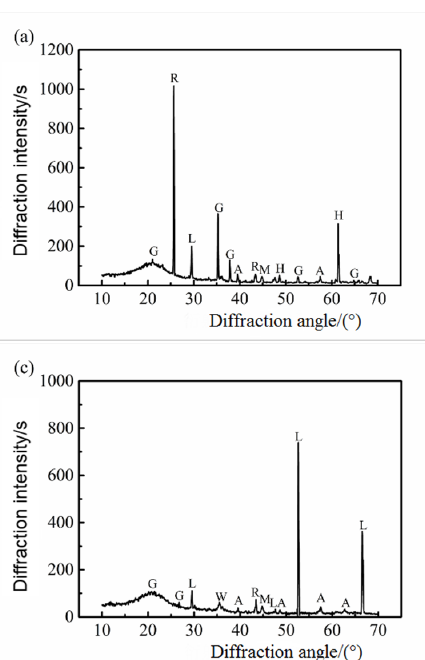
Figure 5. XRD patterns of rust sample of steel bar in seawater sea-sand concrete; ( a ) Inner rust layer of A1, ( b ) Outer rust layer of A1, ( c ) Inner rust layer of A2, ( d ) Outer rust layer of A2.